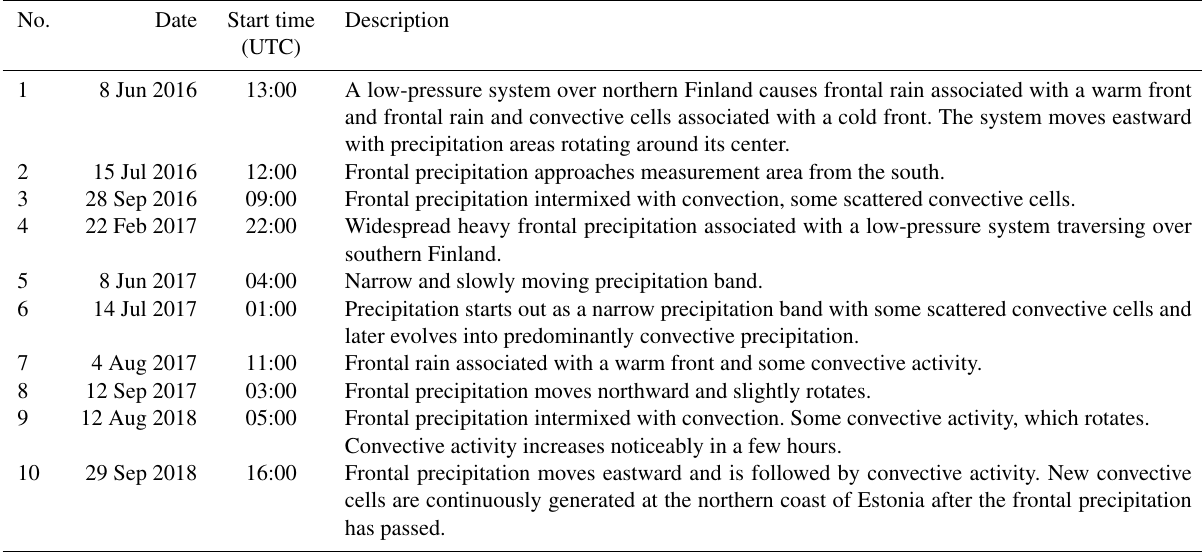
Table 7. Precipitation events in Finland (FMI). The duration of each event is 12h. No.